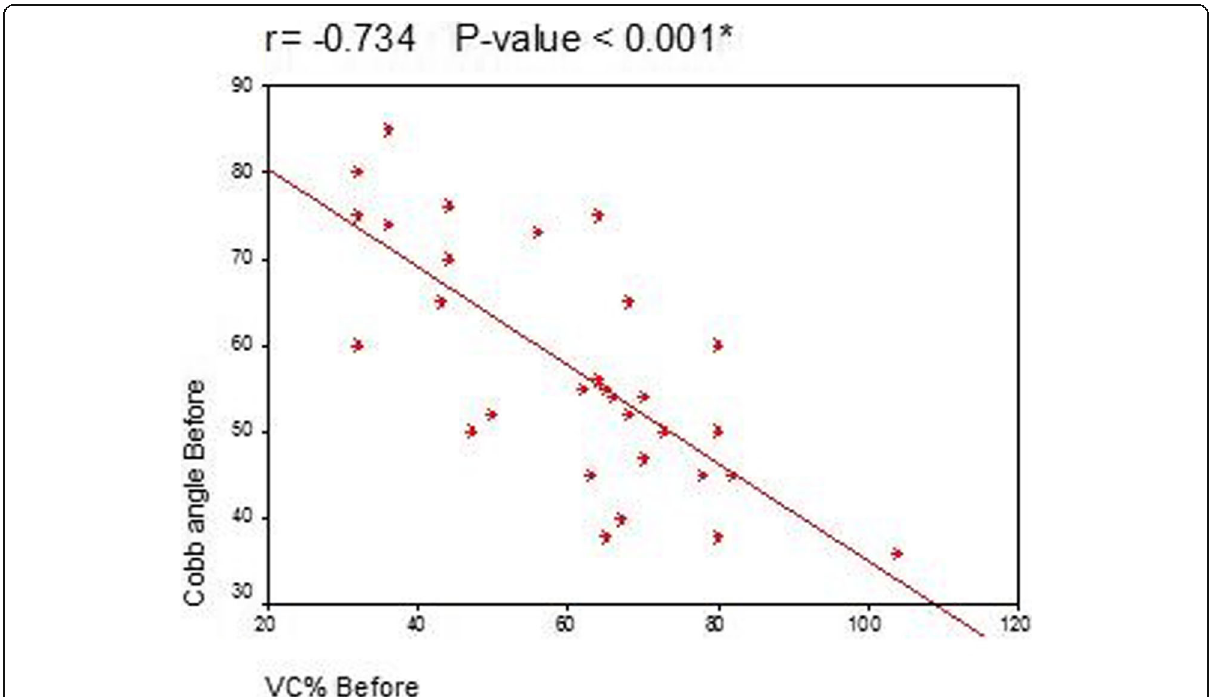
Fig. 1 Correlation between Cobb ’ s angle and VC before operation. Pearson correlation coefficient, the sign before “ r ” denotes the direction of relation, P < 0.05 considered